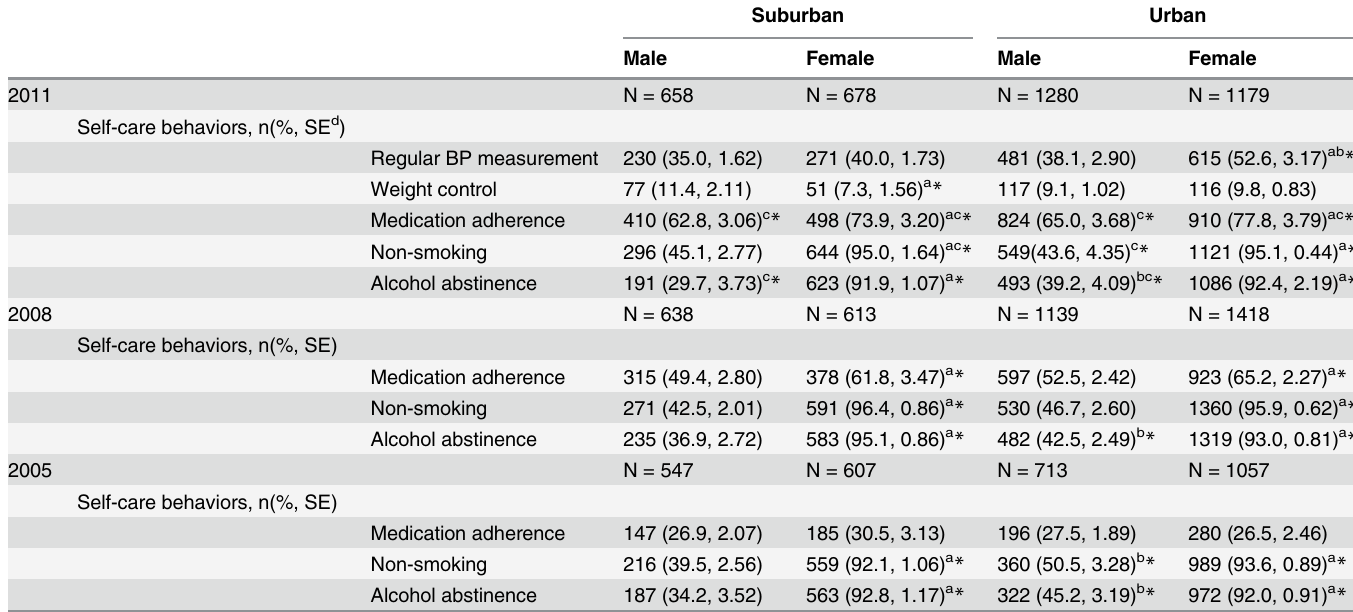
Table 3. Self-care behaviors among patients who were aware of their hypertension in Beijing from 2005 to 2011.